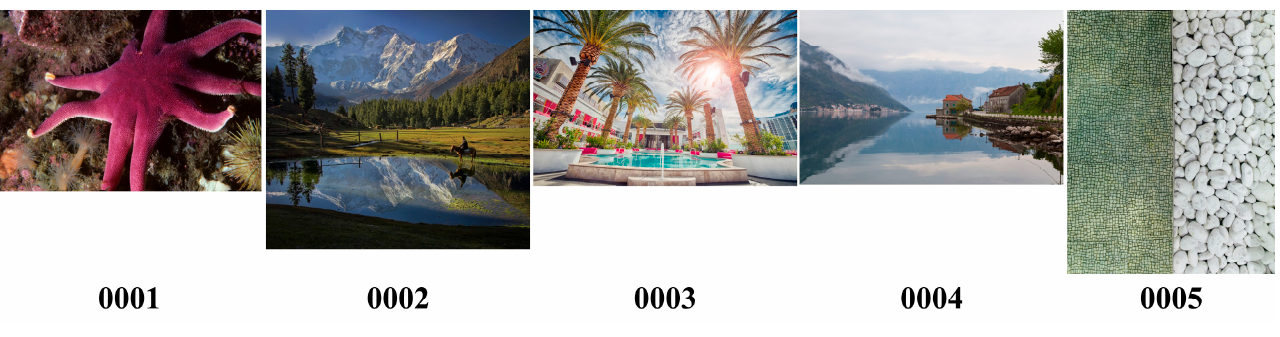
Figure 7. Typical set of images used in experiment.